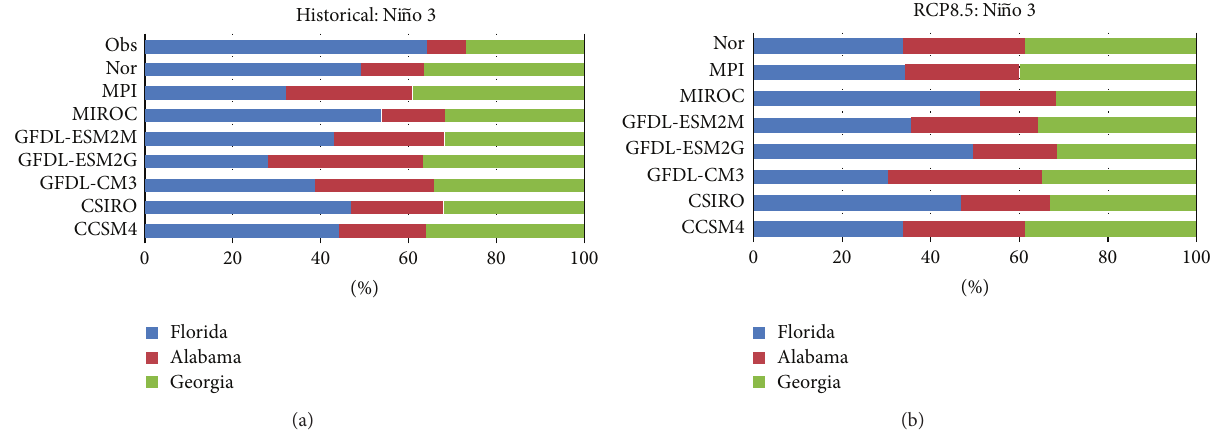
Figure 4: Percentage of the explained variance of Florida, Alabama, and Georgia contributes to a total explained variance of southeastern US spanning 3 states for historical (a) and RCP8.5 (b) experiments from CMIP5 models.